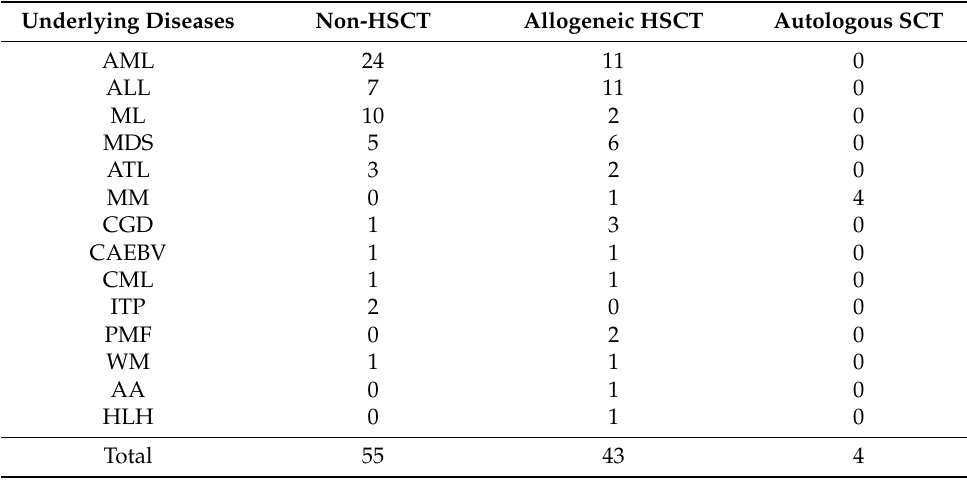
Table 2. Patient characteristics: underlying diseases and transplant